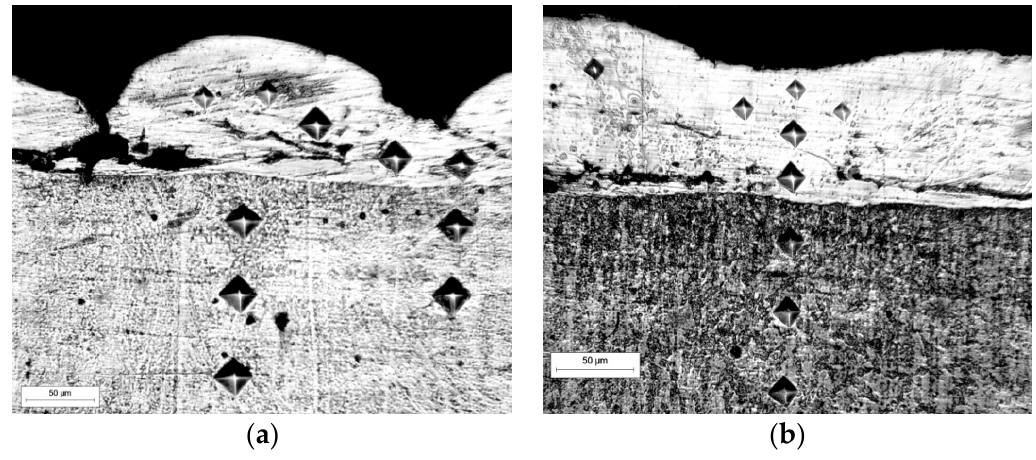
Figure 8. The structure of samples from steel C45 with TiAlC coatings, obtained by successive processing with electrodes from Ti, Al, and graphite in a vibrating mode ( a ) and with rotating wire electrodes in a plane perpendicular to the cathode surface ( b ).